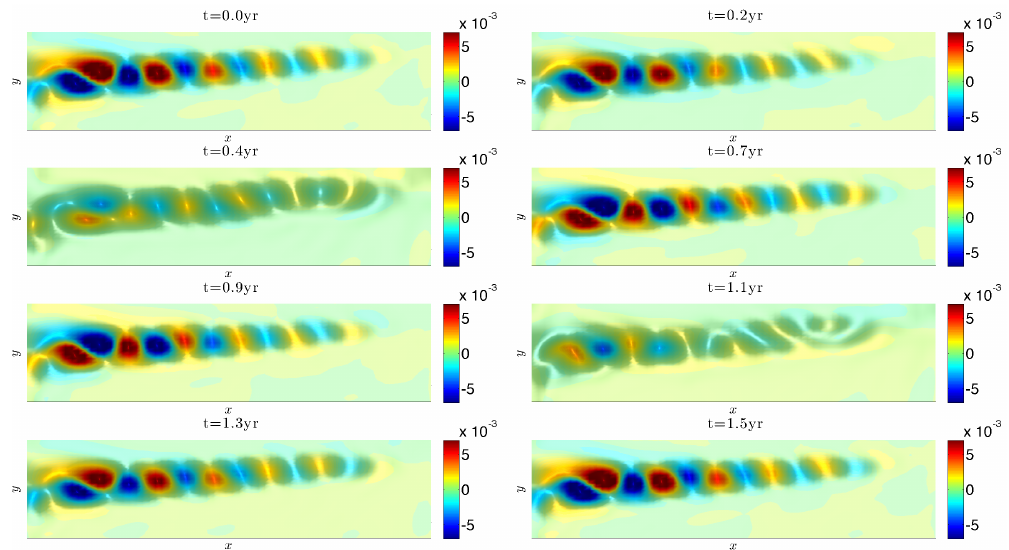
Figure 6. Same as in Figure 5, but for the pair of DAHMs associated with the largest | λ j | (top green dot in Figure 2) at the interannual frequency f I = 0.674 y − 1 (with period ≈ 1.5 y ) (cf. Figure